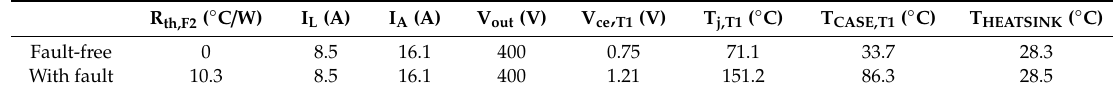
Table 3. Results for the functional test of the IGBT.